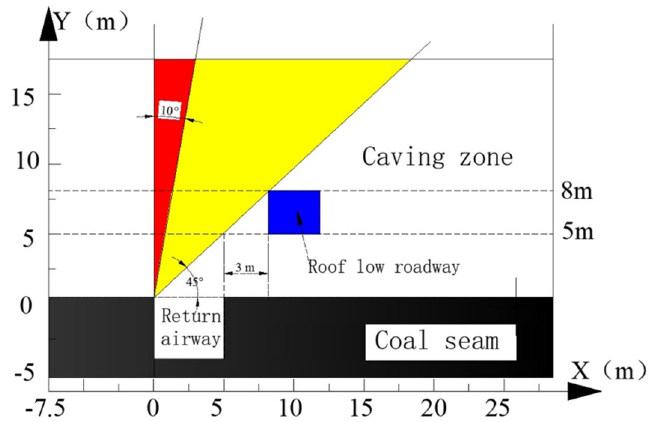
Figure 5. Schematic diagram of the roof low roadway.